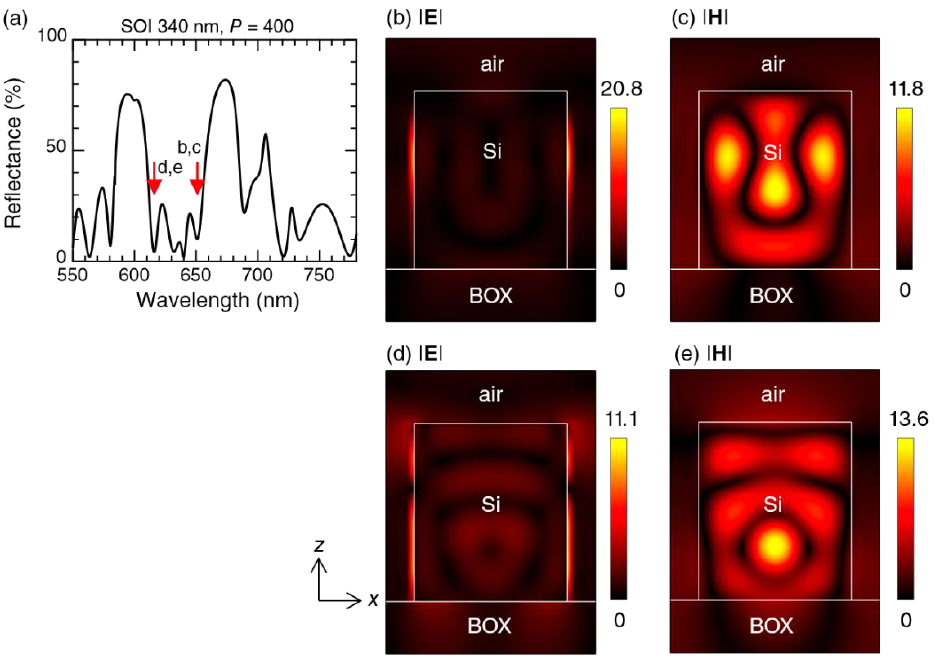
Figure 7. ( a ) Numerically calculated R spectrum for the metasurface of SOI-thickness 200 nm and P = 340 nm. Incidence was assumed to be normal. ( b , c ) xz -section views of | E | and | H | distributions, respectively, at the wavelength (651.0 nm), indicated by the arrow with the label b,c in ( a ). ( d , e ) | E | and | H | distributions, respectively, at the wavelength (616.1 nm), indicated by the arrow with the label d,e in ( a ). Incident | E | and | H | were set to 1.0.